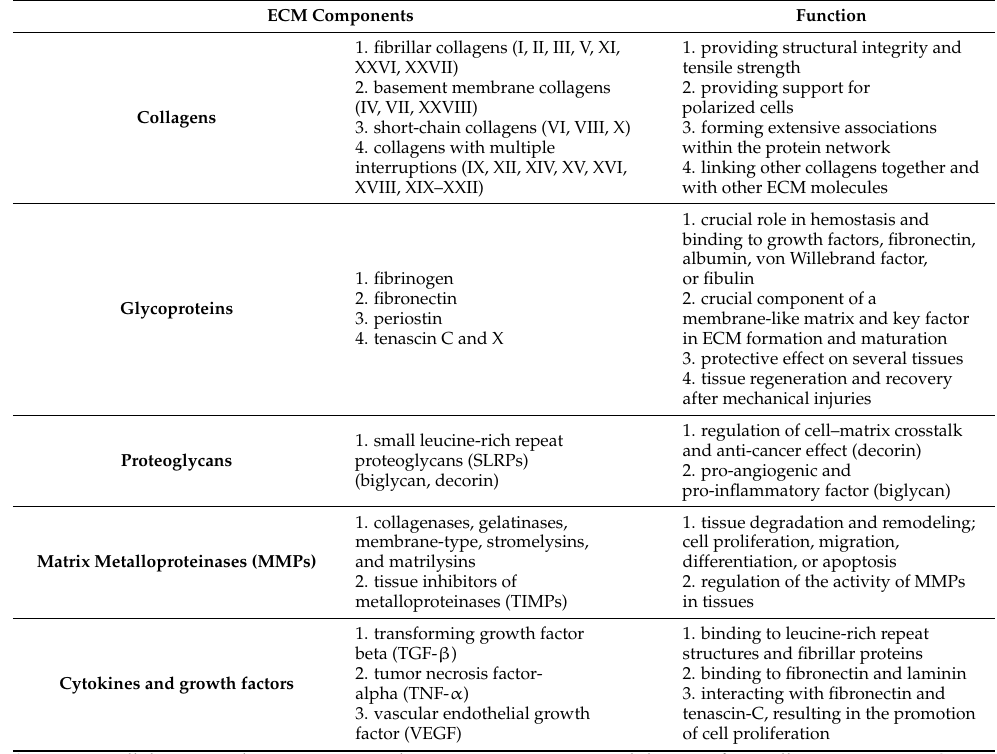
Table 2. The components and their function in healthy